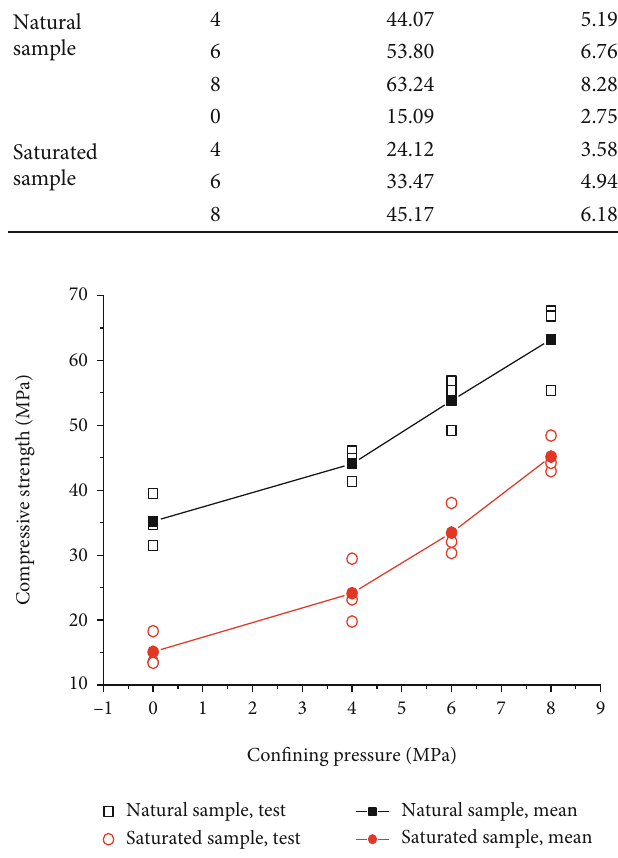
Figure 6: The relationship between compressive strength and con fi ning pressure of natural and fully saturated rock